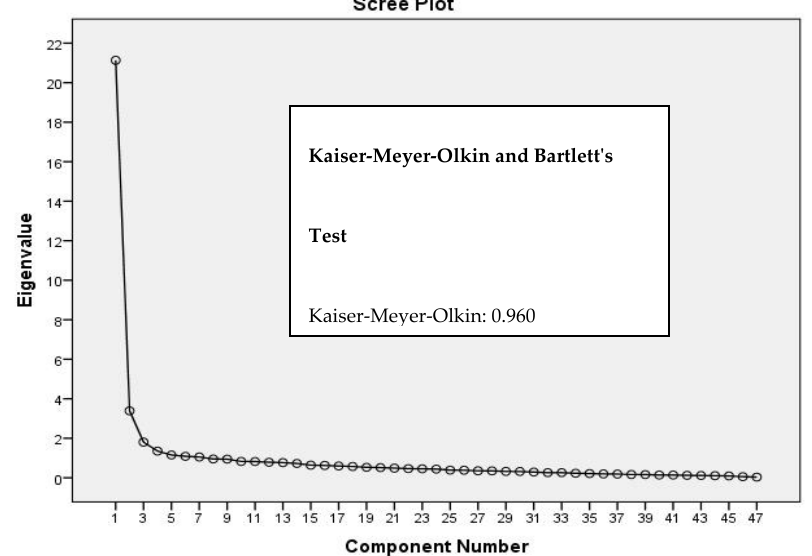
Figure 1. Scree plot of Horn’s parallel analysis.